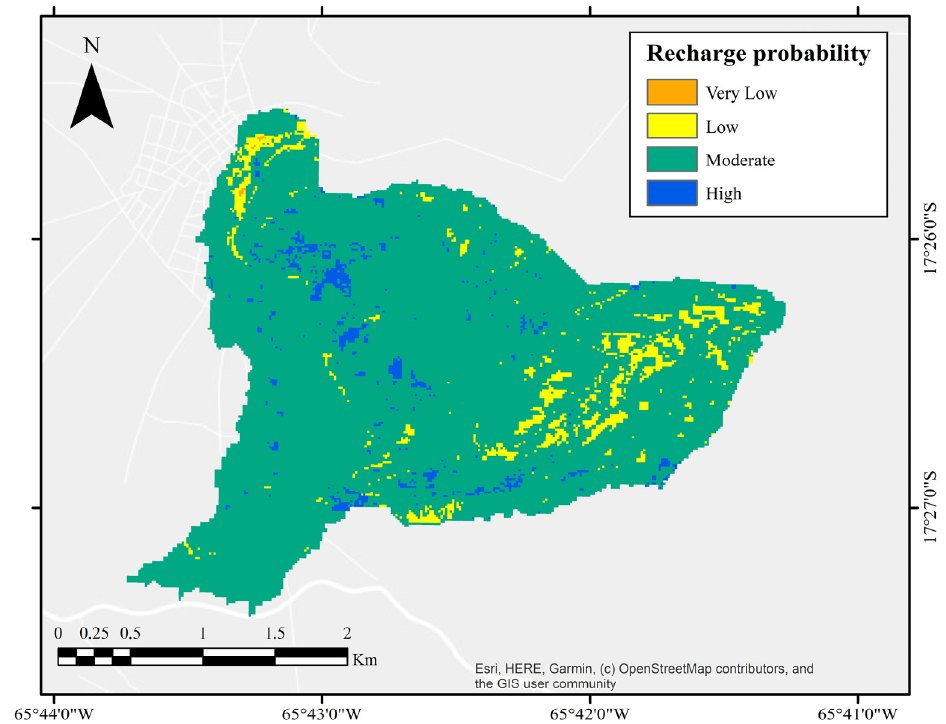
Figure 7. Map of the groundwater recharge probability for the Virvini micro-basin, according to the Matus et al. [46] equation.